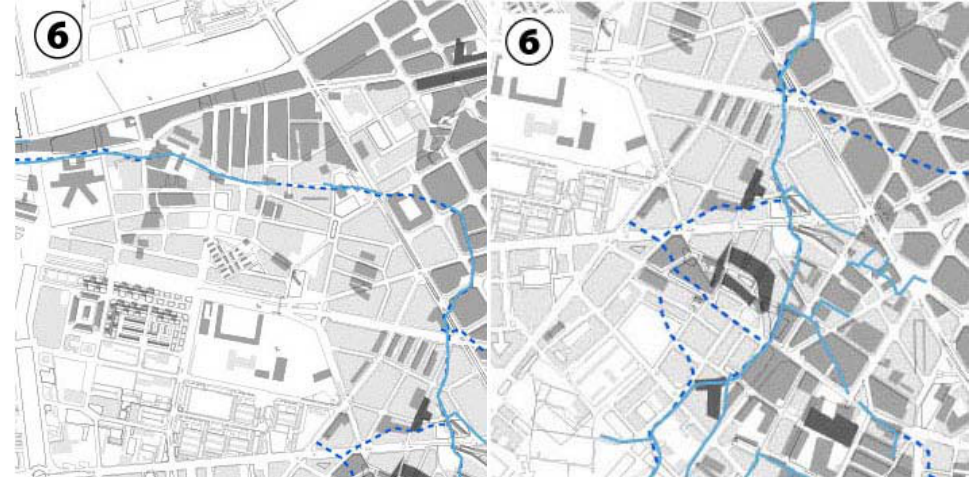
Figure 11. In the areas labeled ⑥, the canals preserved in urban space in